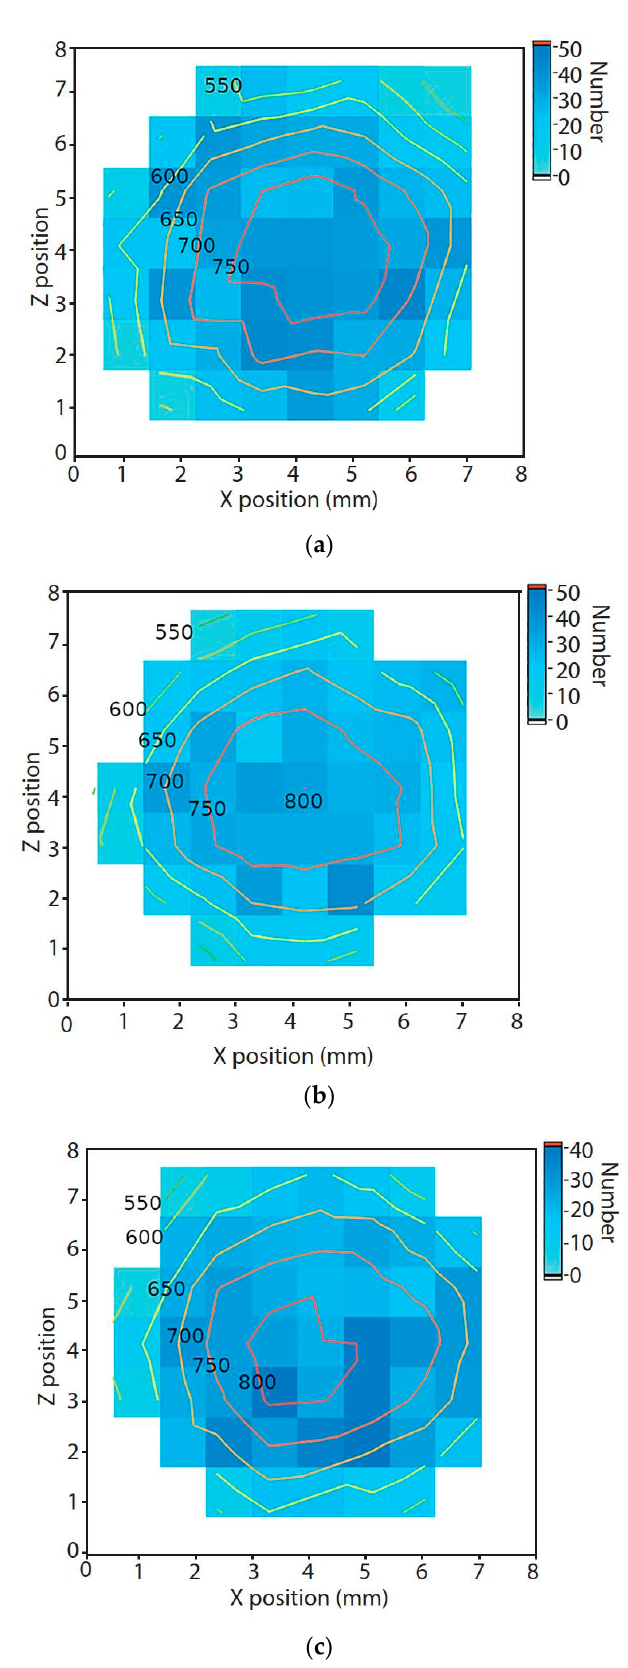
Figure 5. 2D velocity scan maps. Cold spraying of Al6061 powder with ( a ) 30 bar and 400 °C, ( b ) 35 bar and 400 °C, and ( c ) 40 bar and 400 °C. Contour lines show velocity. Colored maps present particle densities. Scan area is 8 × 8 mm 2 .